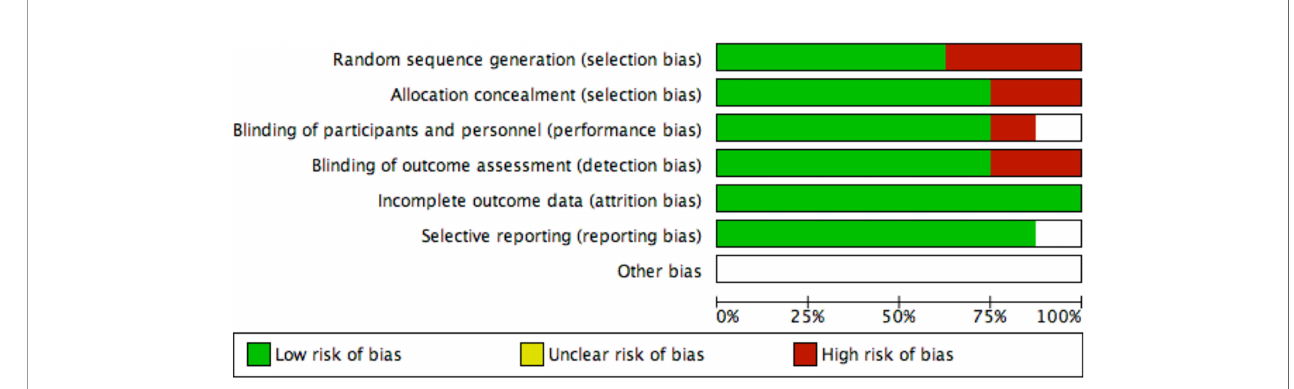
FIGURE 2 | Risk of bias